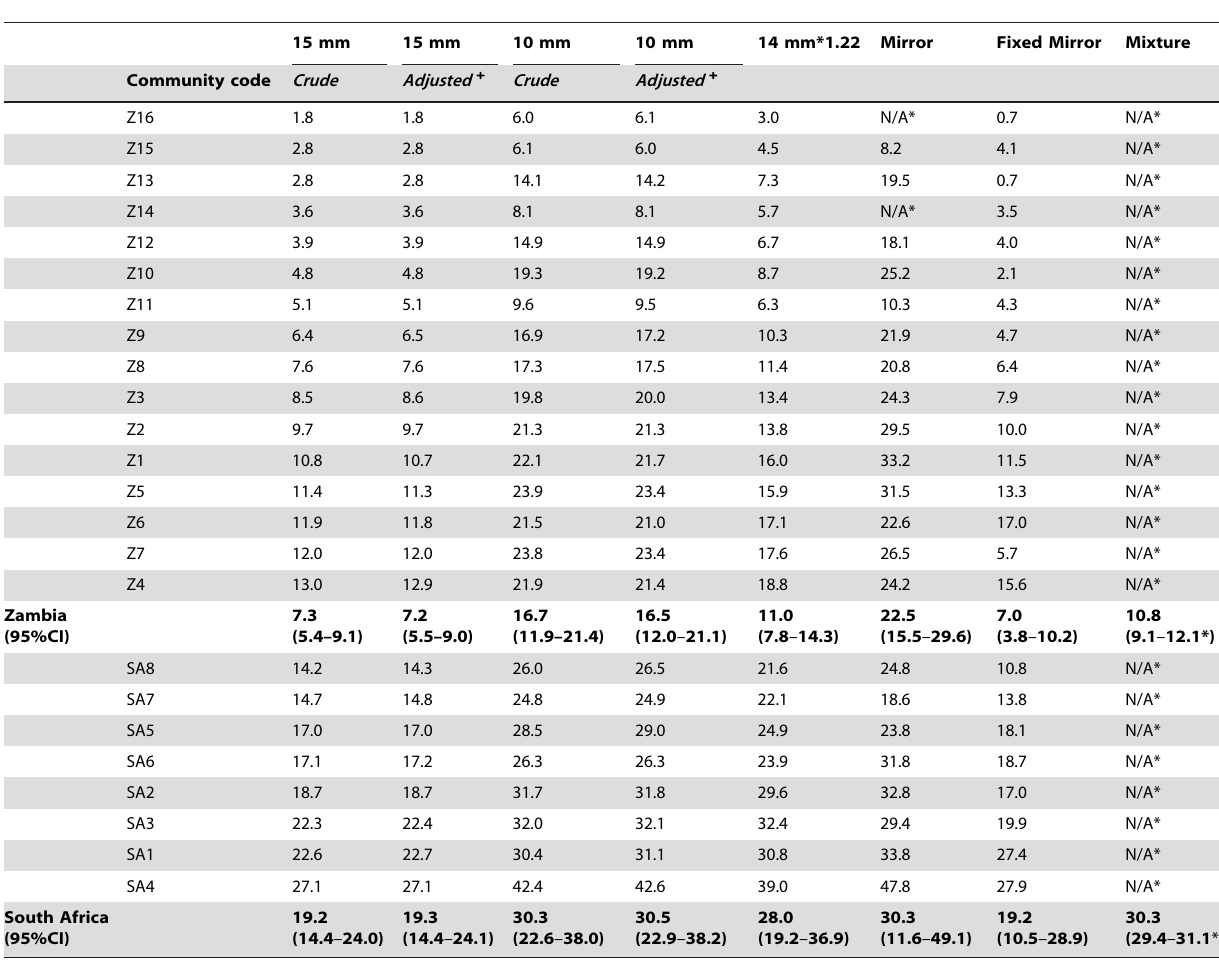
Table 2. Tuberculous infection prevalence estimates by community and